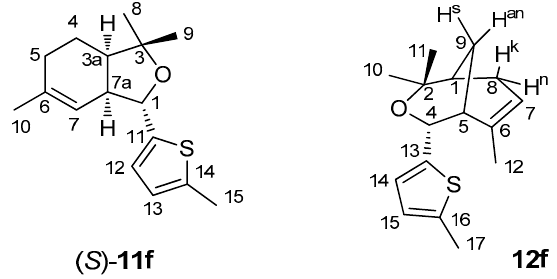
Figure 6. Numeration of carbon atoms for NMR spectra. Figure 5. Numeration of carbon atoms for NMR